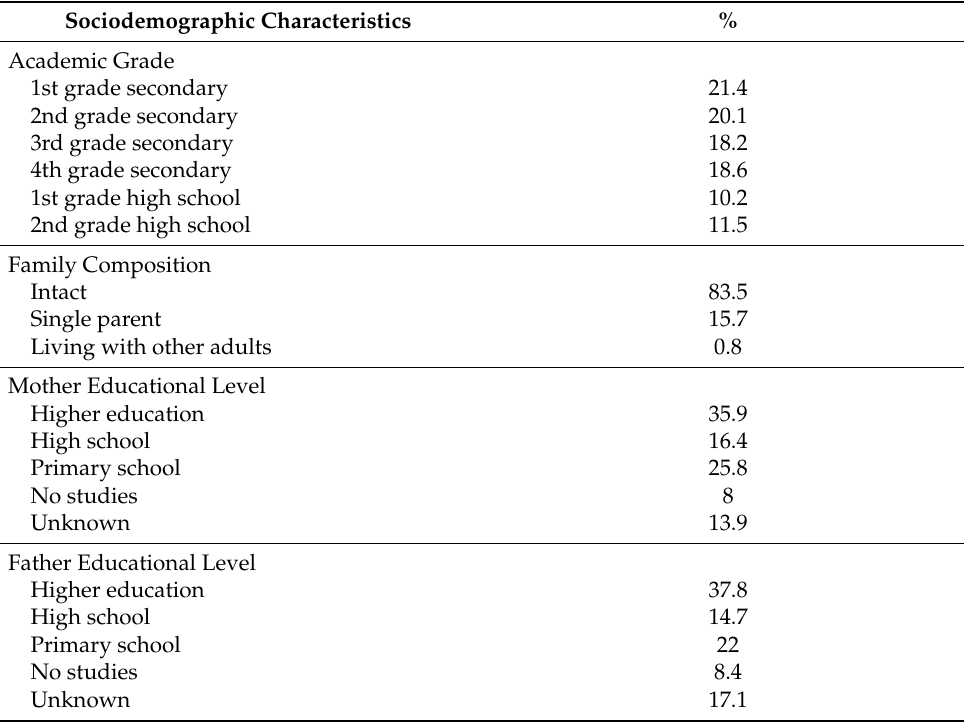
Table 1. Sociodemographic characteristics of the